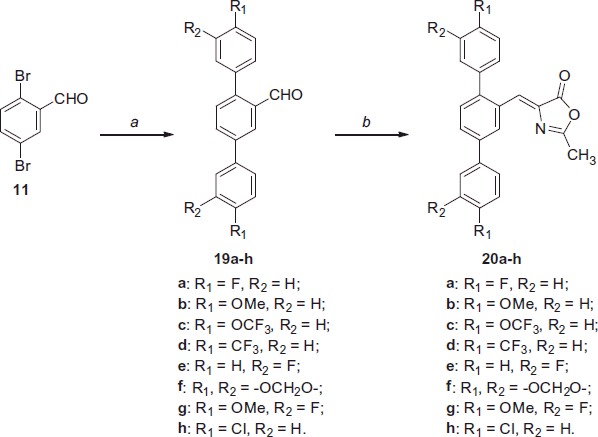
Reagents and conditions: (a) variously substituted phenylboronic acid, Pd(OAc)2, PPh3, aq. 2 M Na2CO3, toluene, EtOH, 100 °C; (b) N-acetylglycine, Ac2O, CH3COONa, reflux.